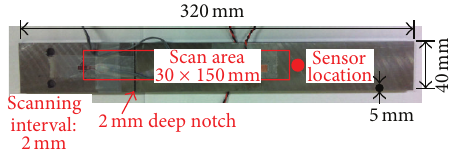
Figure 7: Configuration of a specimen with a notch (target to detect).